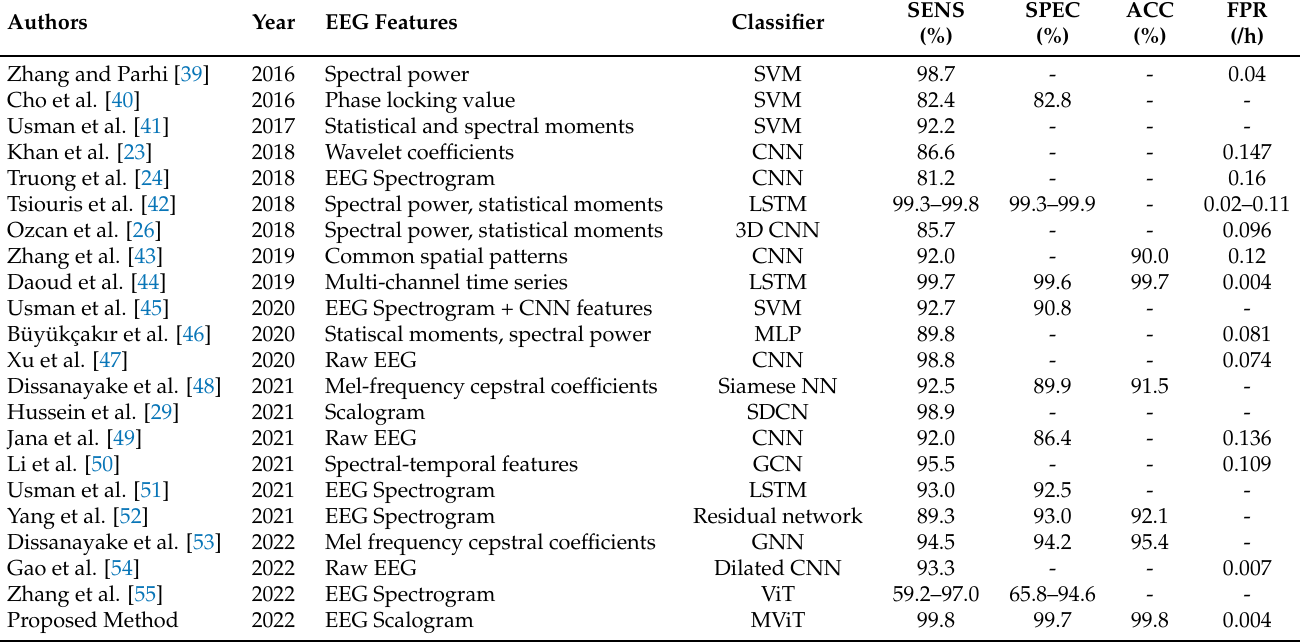
Table 1. Benchmarking of the previous seizure-prediction methods and our MViT approach: CHB– MIT EEG